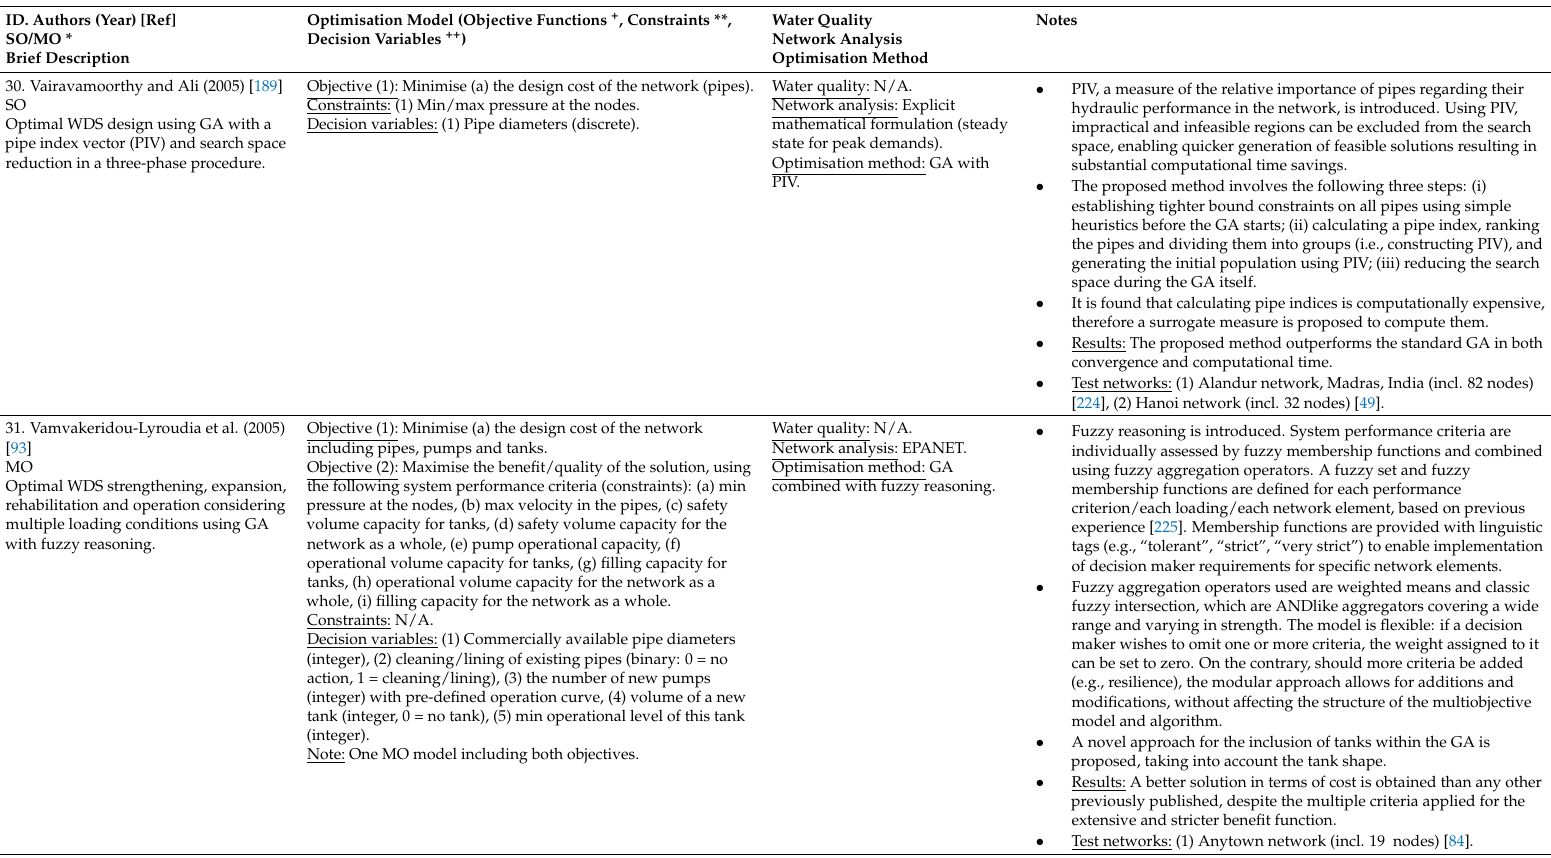
30. Vairavamoorthy and Ali (2005) [189] SO Optimal WDS design using GA with a pipe index vector (PIV) and search space reduction in a three-phase procedure.